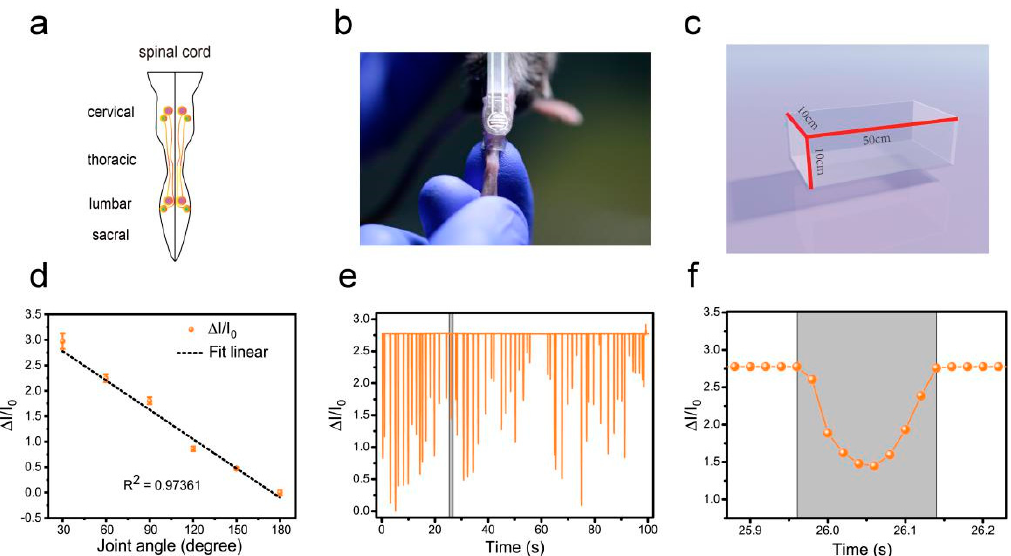
Figure 5. Hindlimb locomotion in open field task (intact mice). ( a ) The pattern of the spinal cord. ( b ) Image of attaching the pressure sensor and the TPE sleeve. ( c ) Plexiglas box for locomotion testing. ( d ) The current rate curve corresponding to different angles (ankle joint). ( e ) Hindlimb locomotion of an intact mouse and its corresponding relative current. ( f ) An enlarged view of one of the actions in part e.